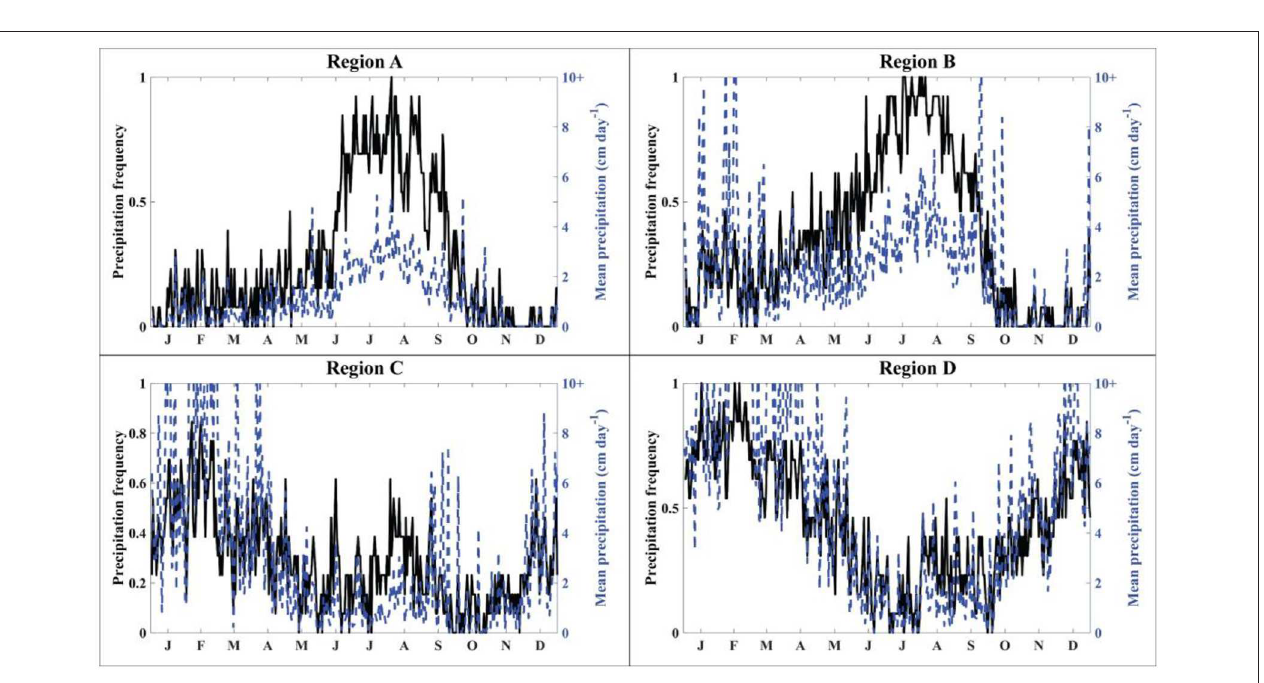
FIGURE 6 | Precipitation frequency (black line) and mean precipitation (blue dashed line) averaged for each day (e.g., each 1 March is averaged) across 2001–2013 for each region. Precipitation frequency as presented here is the number of times a given day exhibited precipitation divided by the total number of years of data (13). For example, if it rained all 13 years on 1 June, then the precipitation frequency for that day would be 1. 15), potentially further decreasing snowpack thickness, and (3) snows, (1) the snowpack is thinner ( 1 d is negative relative surface albedo is not reset (s stays the same, rather than being to the control; Equation 5), (2) rain now supplies heat to set equal to i as in the control; Equation 6). All three the surface ( 1 Q P is positive relative to the control; Equation